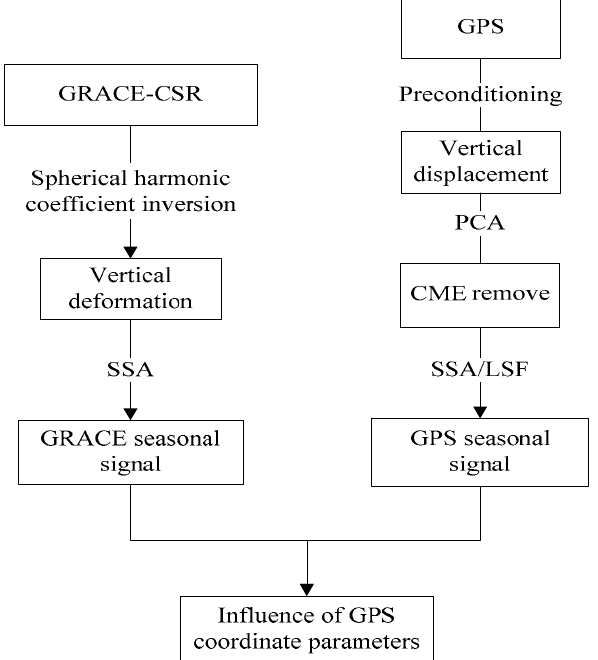
Figure 2. Flowchart describes the main steps of analyzing the seasonal variation of surface vertical deformation in Greenland and its influence by GRACE and GPS data. For more details refer to Section 3.